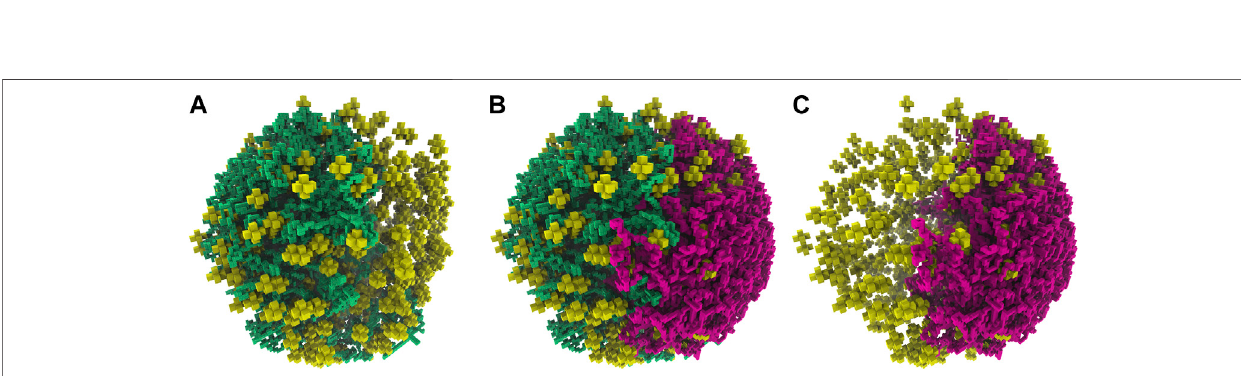
FIGURE 10 | (A) — First chromosome (green) generated within the large cell architecture of radius 247.42 nm and containing 820 ribosomes (yellow). (B) — An additional second chromosome (magenta) was generated within the large cell architecture while avoiding the fi rst chromosome (green). (C) — The isolated second chromosome (magenta) in the large cell architecture after the removal of the fi rst